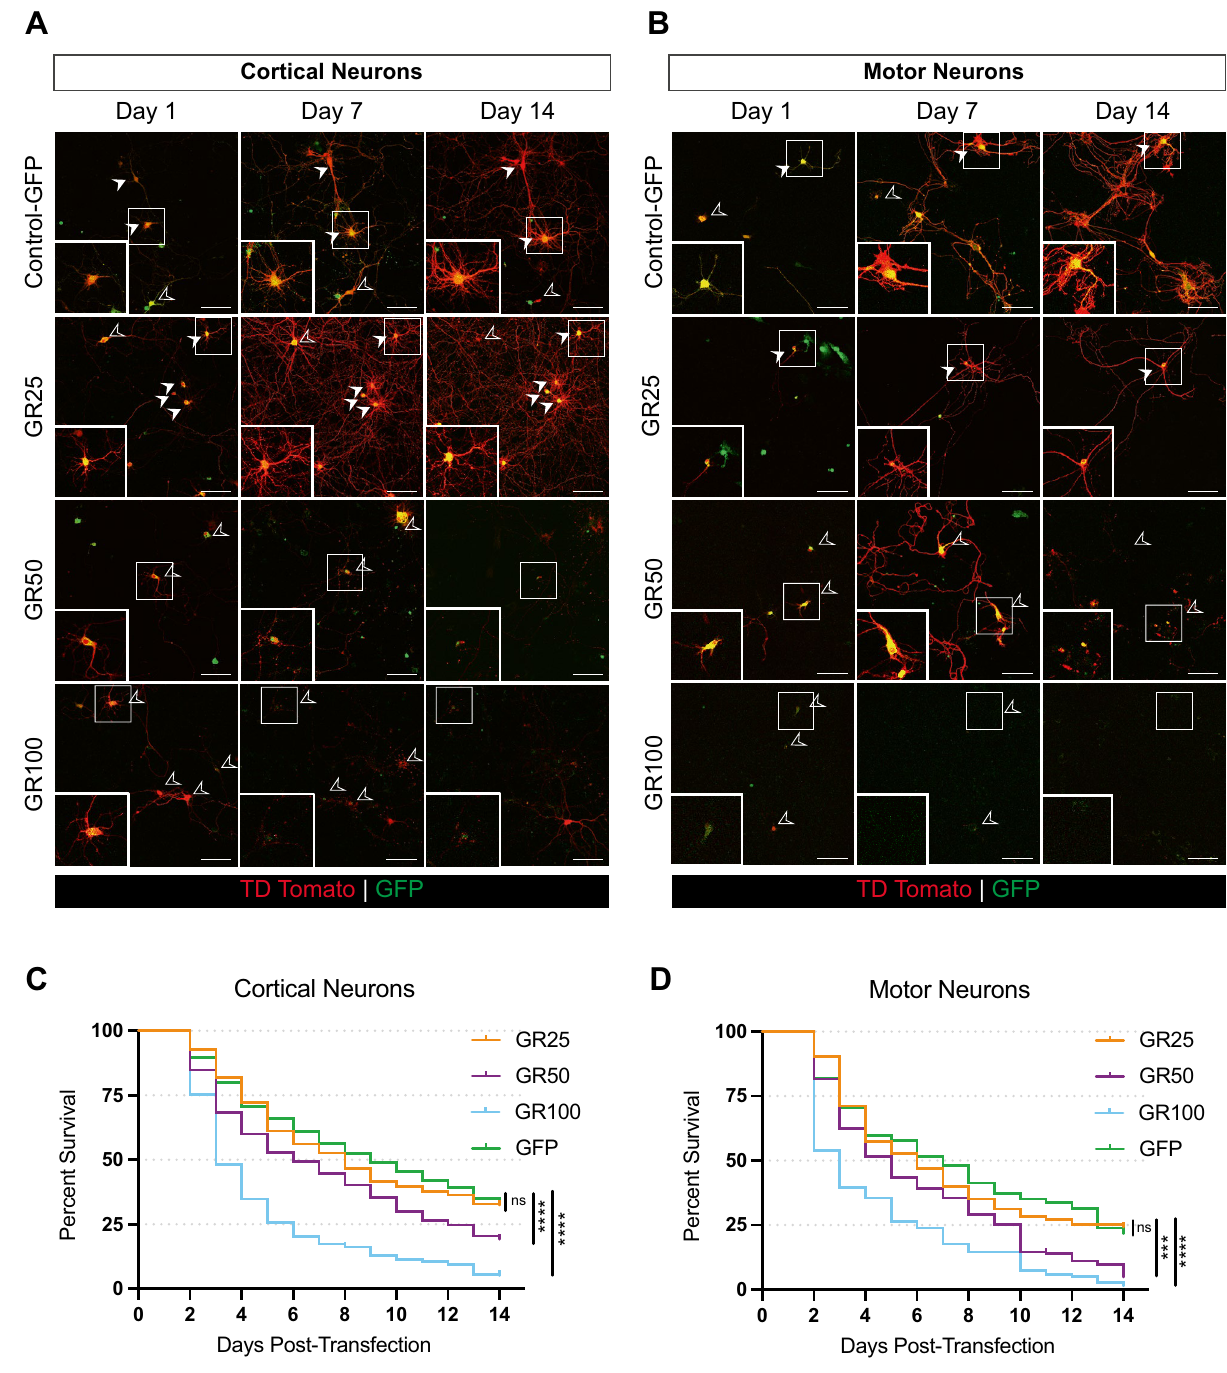
Figure 1. GR50 neurotoxic profile in vitro. Primary cortical neurons ( A ) and motor neurons ( B ) co-transfected with 125 ng td-tomato and 400 ng of GFP-tagged GR constructs of length 25, 50, 100, or GFP. Scale bar 100 µm. Inset shows cells that are double-positive for td-tomato and GFP-tagged construct of interest. Closed arrows indicate cells that survive over the 14-day observation period. Open arrows indicate cells that die over the time-course of the experiment. Log-rank longitudinal survival assessment of co-transfected td-tomato and GFP-GR25, 50, 100, or GFP alone quantified for primary corticals in ( C ) and motor neurons ( D ) over 14 days. Cells (m) pooled from n = 3 independent experiments. Primary cortical neurons m = 319 (GFP), 302 (GR25), 348 (GR50), and 263 (GR100). ****p < 0.0001. Primary motor neurons m = 149 (GFP), 105 (GR25), 163 (GR50), and 169 (GR100). ***p = 0.0001, ****p < 0.0001. Cell counts, p-values, and hazard ratios summarized in Tables 1 and